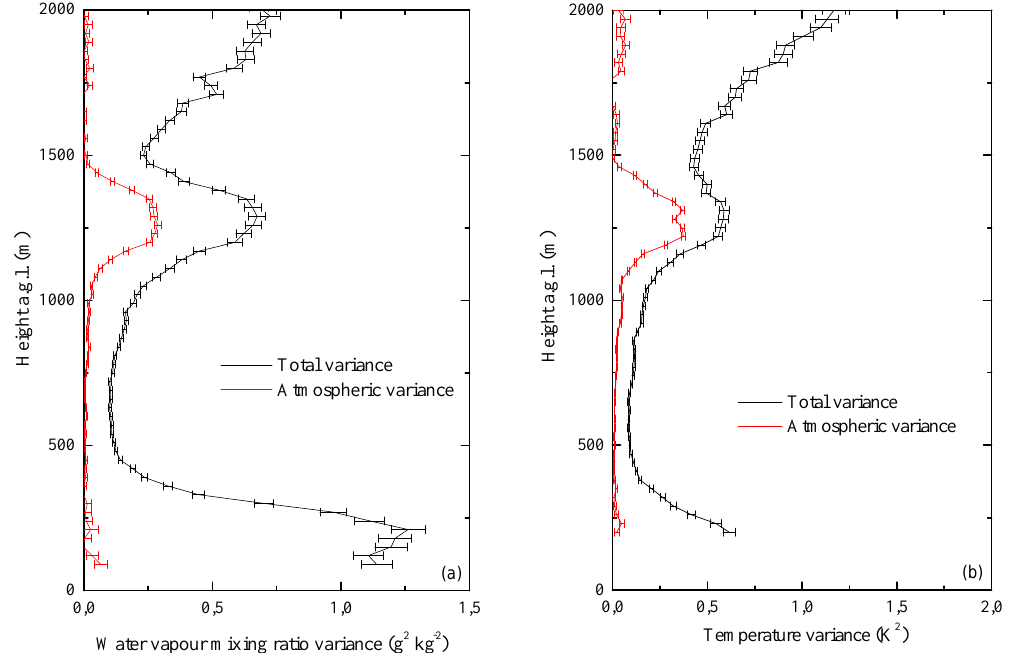
Figure 10. Vertical profiles of atmospheric and total variance for water vapour mixing ratio (a) and temperature (b) computed for the same time interval considered in Fig. 4. In the figure the error bars represent only the noise